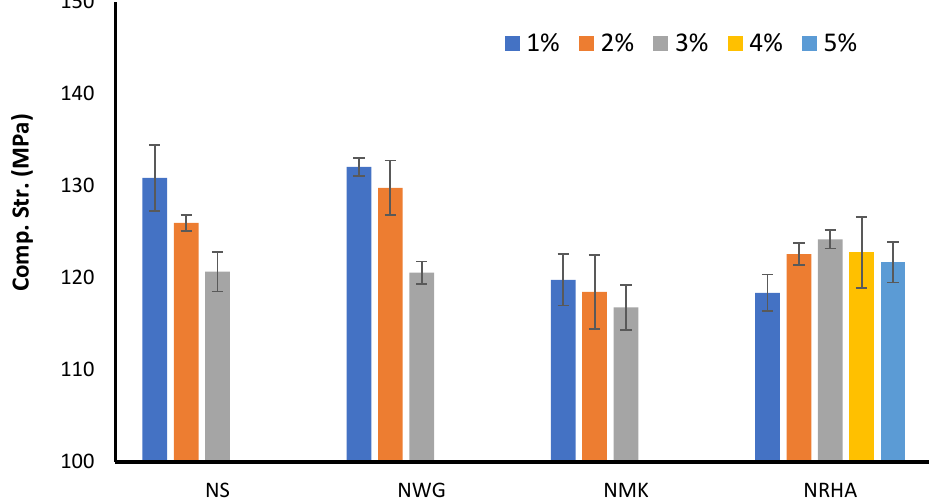
ff erent nanomaterials on UHPC strength at 28 Figure 6. Comparing the influence of different nanomaterials on UHPC strength at 28 days. Figure 6. Comparing the influence of di